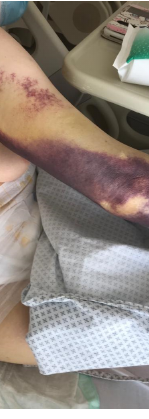
Figure 1. Multiple subcutaneous hematomas present at the physical examination.